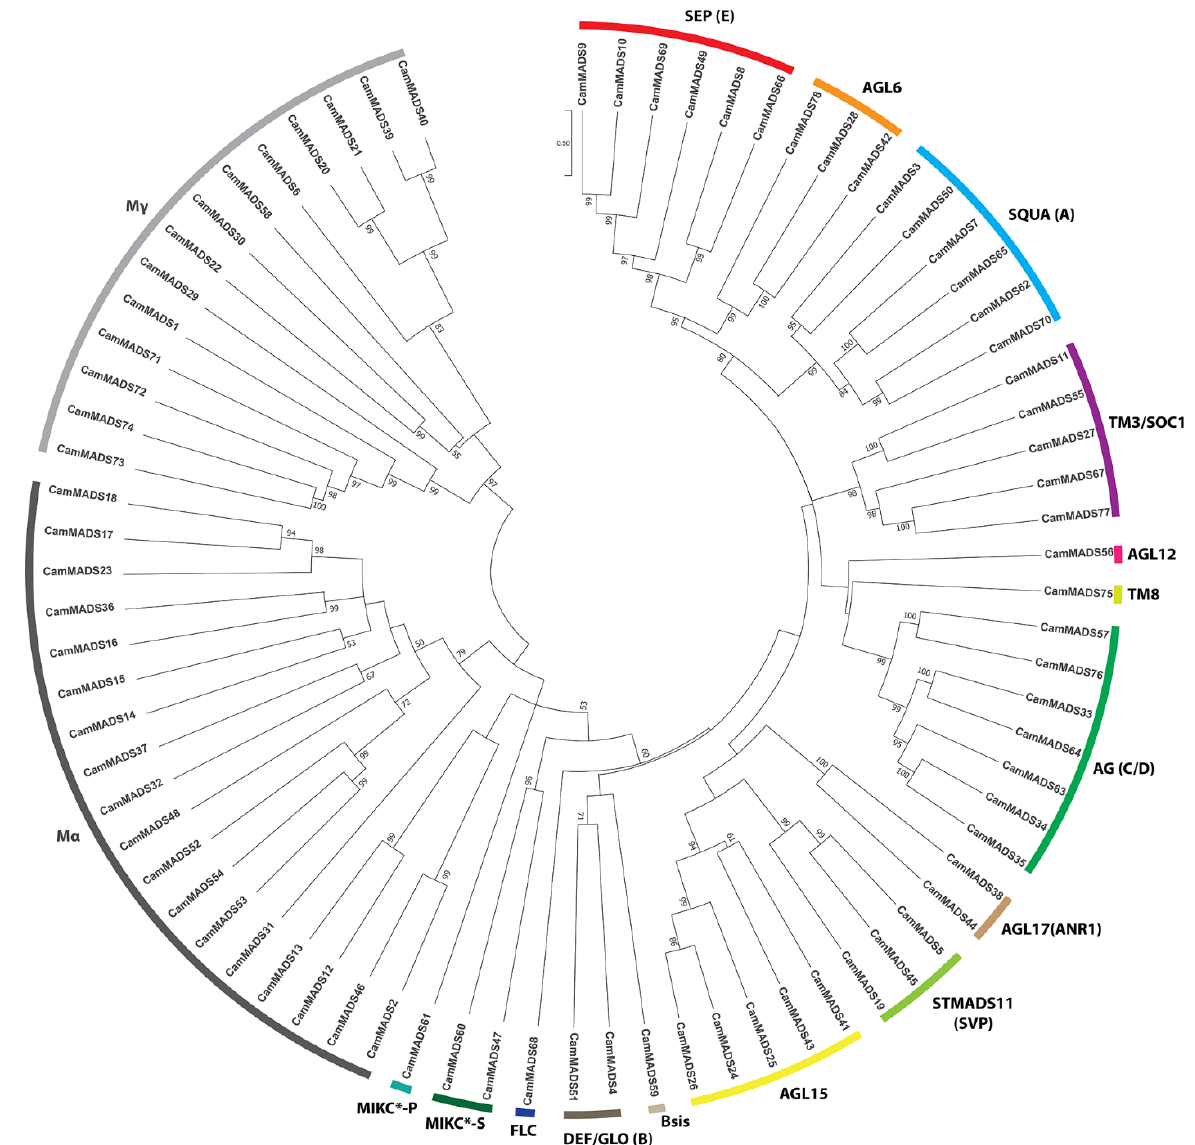
Figure 2. Maximum likelihood tree of CamMADS proteins in C. americana . The tree shows type I subgroups (M α -type, M γ -type), while the type I M β -type group was absent. Type II subgroups; MIKC C (SQUA (A), DEF/GLO (B), AG (C/D), SEP (E), AGL6, AGL12, AGL15, AGL17 (ANR1), Bsis, TM3/SOC1, STMADS11 (SVP), FLC, and TM8. The MIKC* subgroups (MIKC*-S and MIKC*).